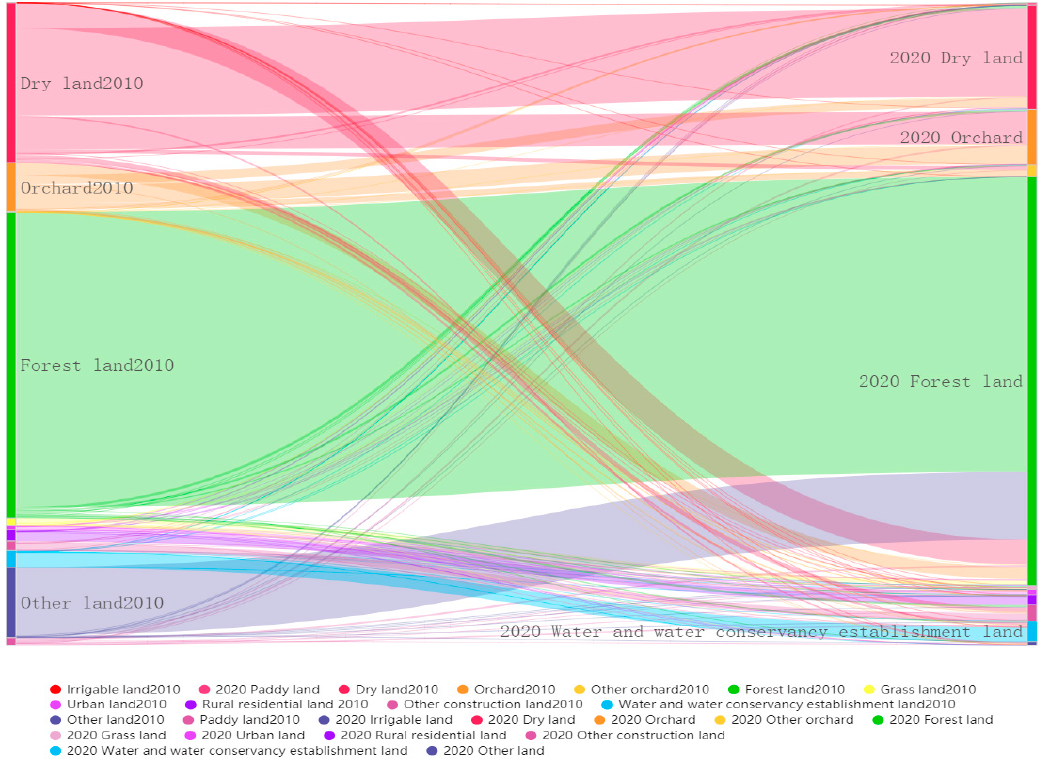
Figure 6. Inflow and outflow of all land types from 2010 to 2020.